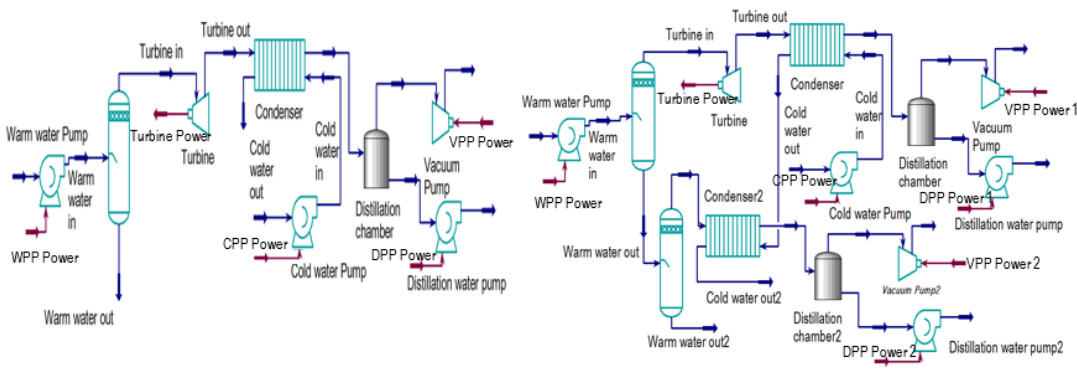
Figure 2. Single-stage open-cycle ocean thermal energy conversion (OTEC) ( left ) and two-stage open-cycle OTEC ( right ).